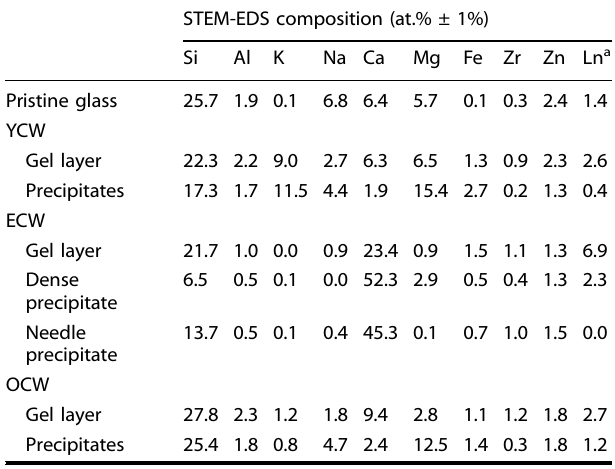
Table 2. Elemental composition (at.%) for the alteration layers of CaZn28 dissolved in synthetic cement solutions, acquired by STEM-